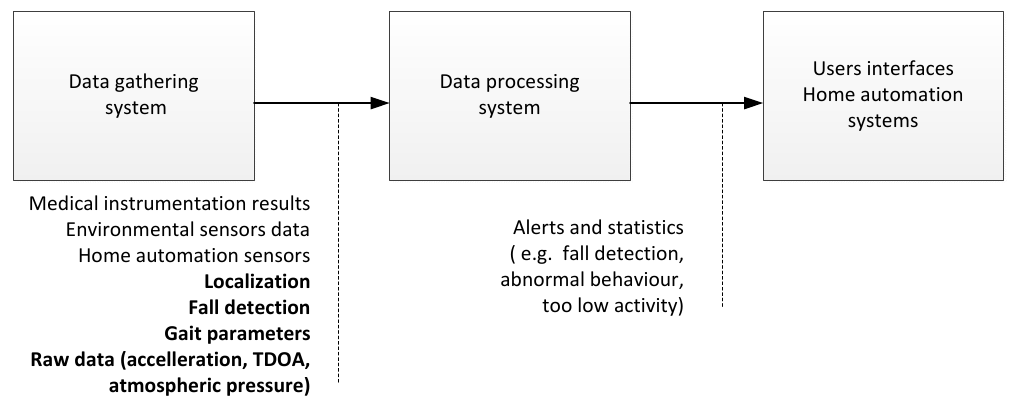
Figure 1. Data processing in Assistive Technologies (AT) platform.